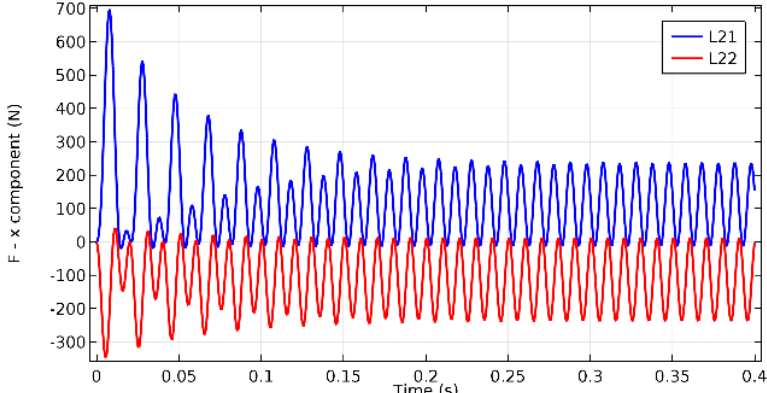
Figure 12. Electrodynamic forces on earthing knifes L21 and L22 obtained by FEM calculation.